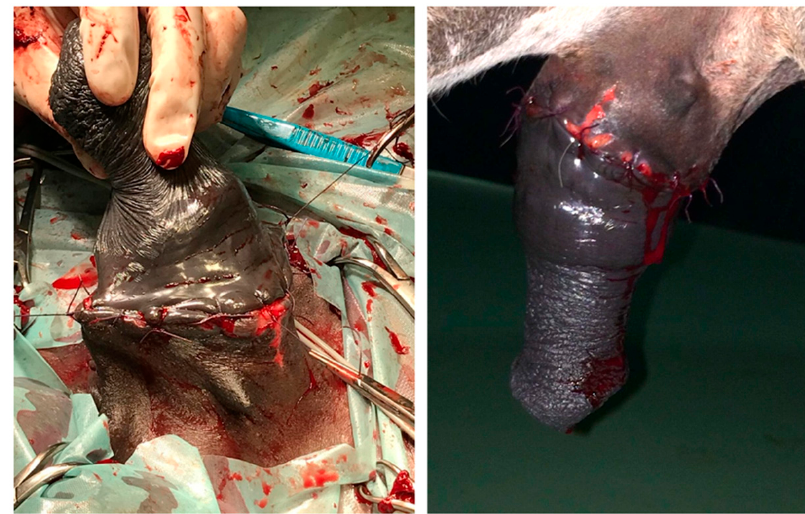
Figure 14. Extensive segmental posthetomy (clinical case 1).